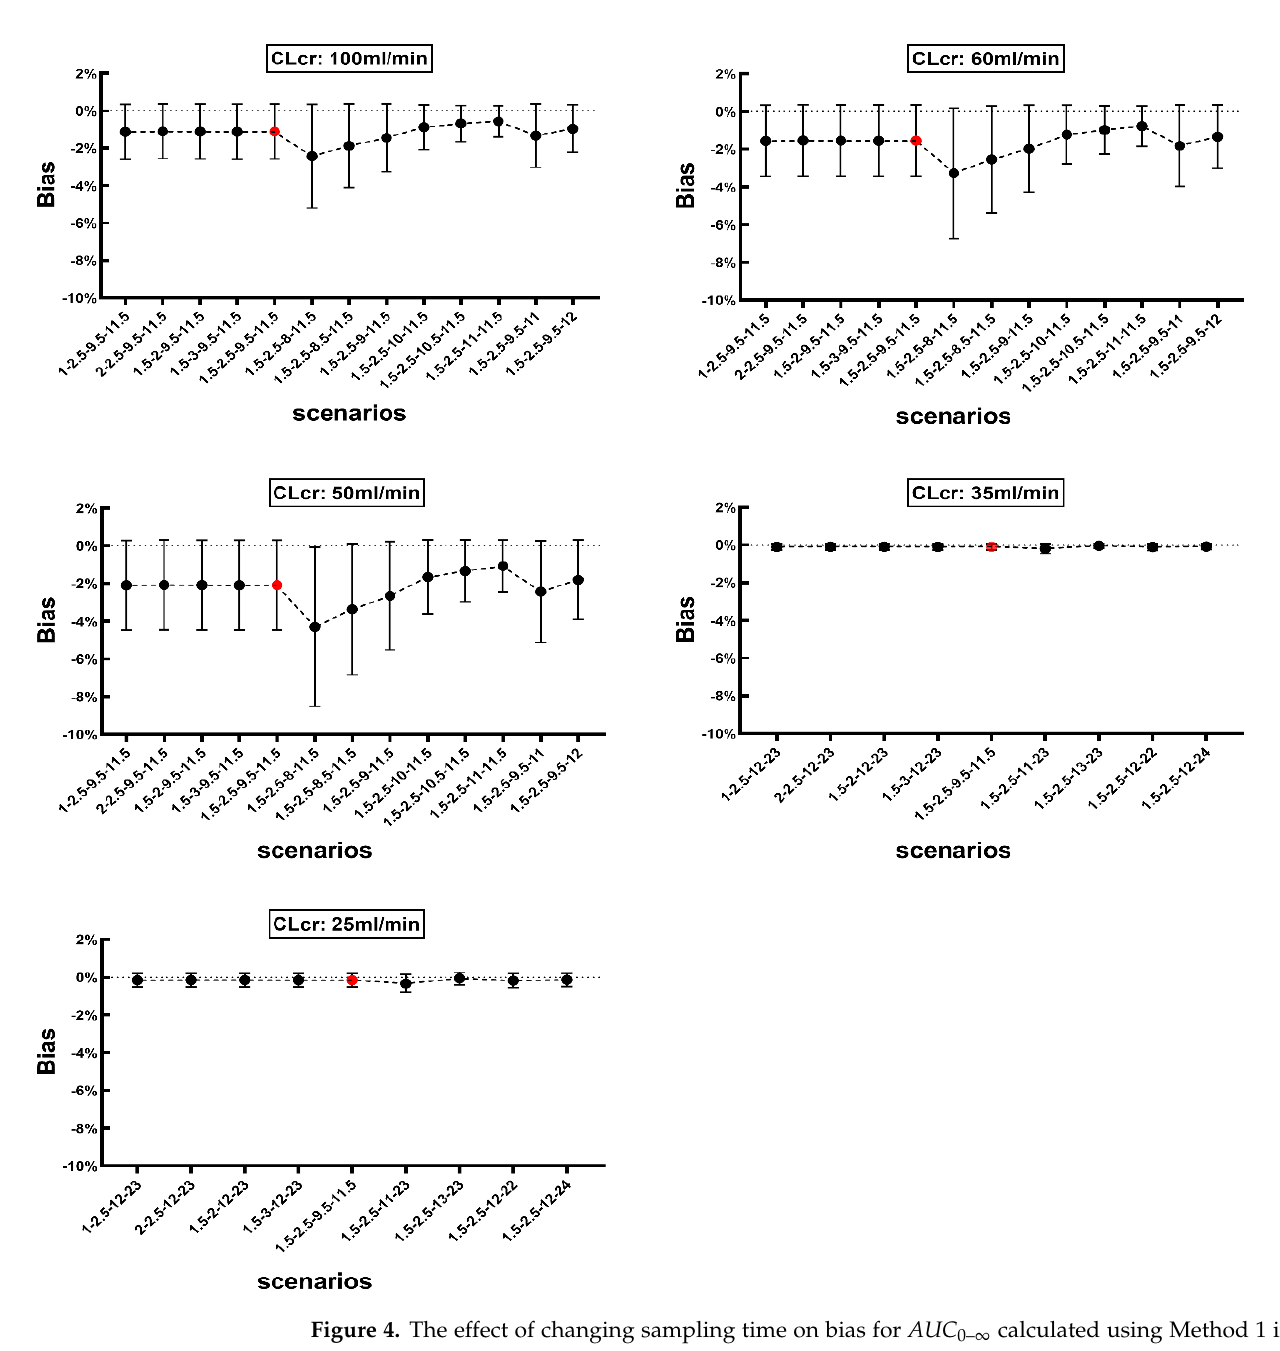
Figure 4. The effect of changing sampling time on bias for AUC 0– ∞ calculated using Method 1 in patients with various degrees of renal function (CLcr: 100, 60, 50, 35, 25 mL/min). Red solid circle represents the mean bias when the four sampling time points set per the schedule, namely 1.5, 2.5, 9.5 and 11.5 h post the initiation of intravenous infusion of vancomycin. Black solid circle represents the mean bias with changing one scheduled sampling time while other three remain unchanged. X axis represents respective sampling time schedule for each patient, for example, 1-2.5-9.5-11.5 represents that the four sampling time points set at 1, 2.5, 9.5 and 11.5 h post the initiation of intravenous infusion of vancomycin. Data is presented as mean and SD.